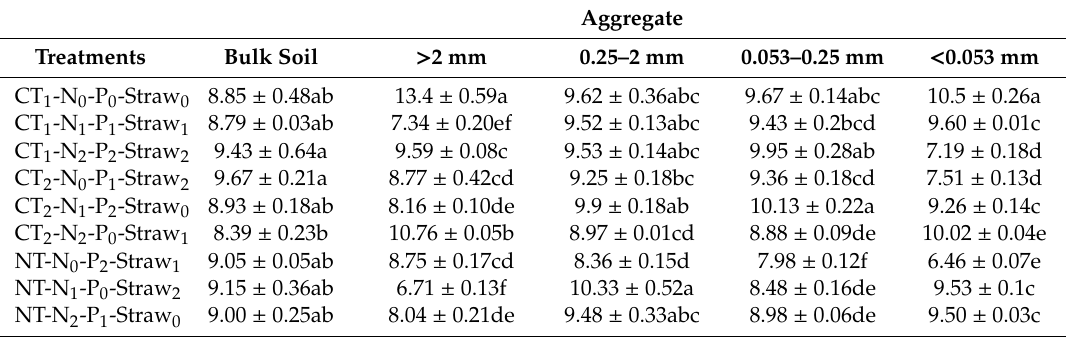
Table 3. The C / N ratios in bulk soil and di ff erent size aggregates at 0–20 cm (Mean ± standard error (SE)) (n =